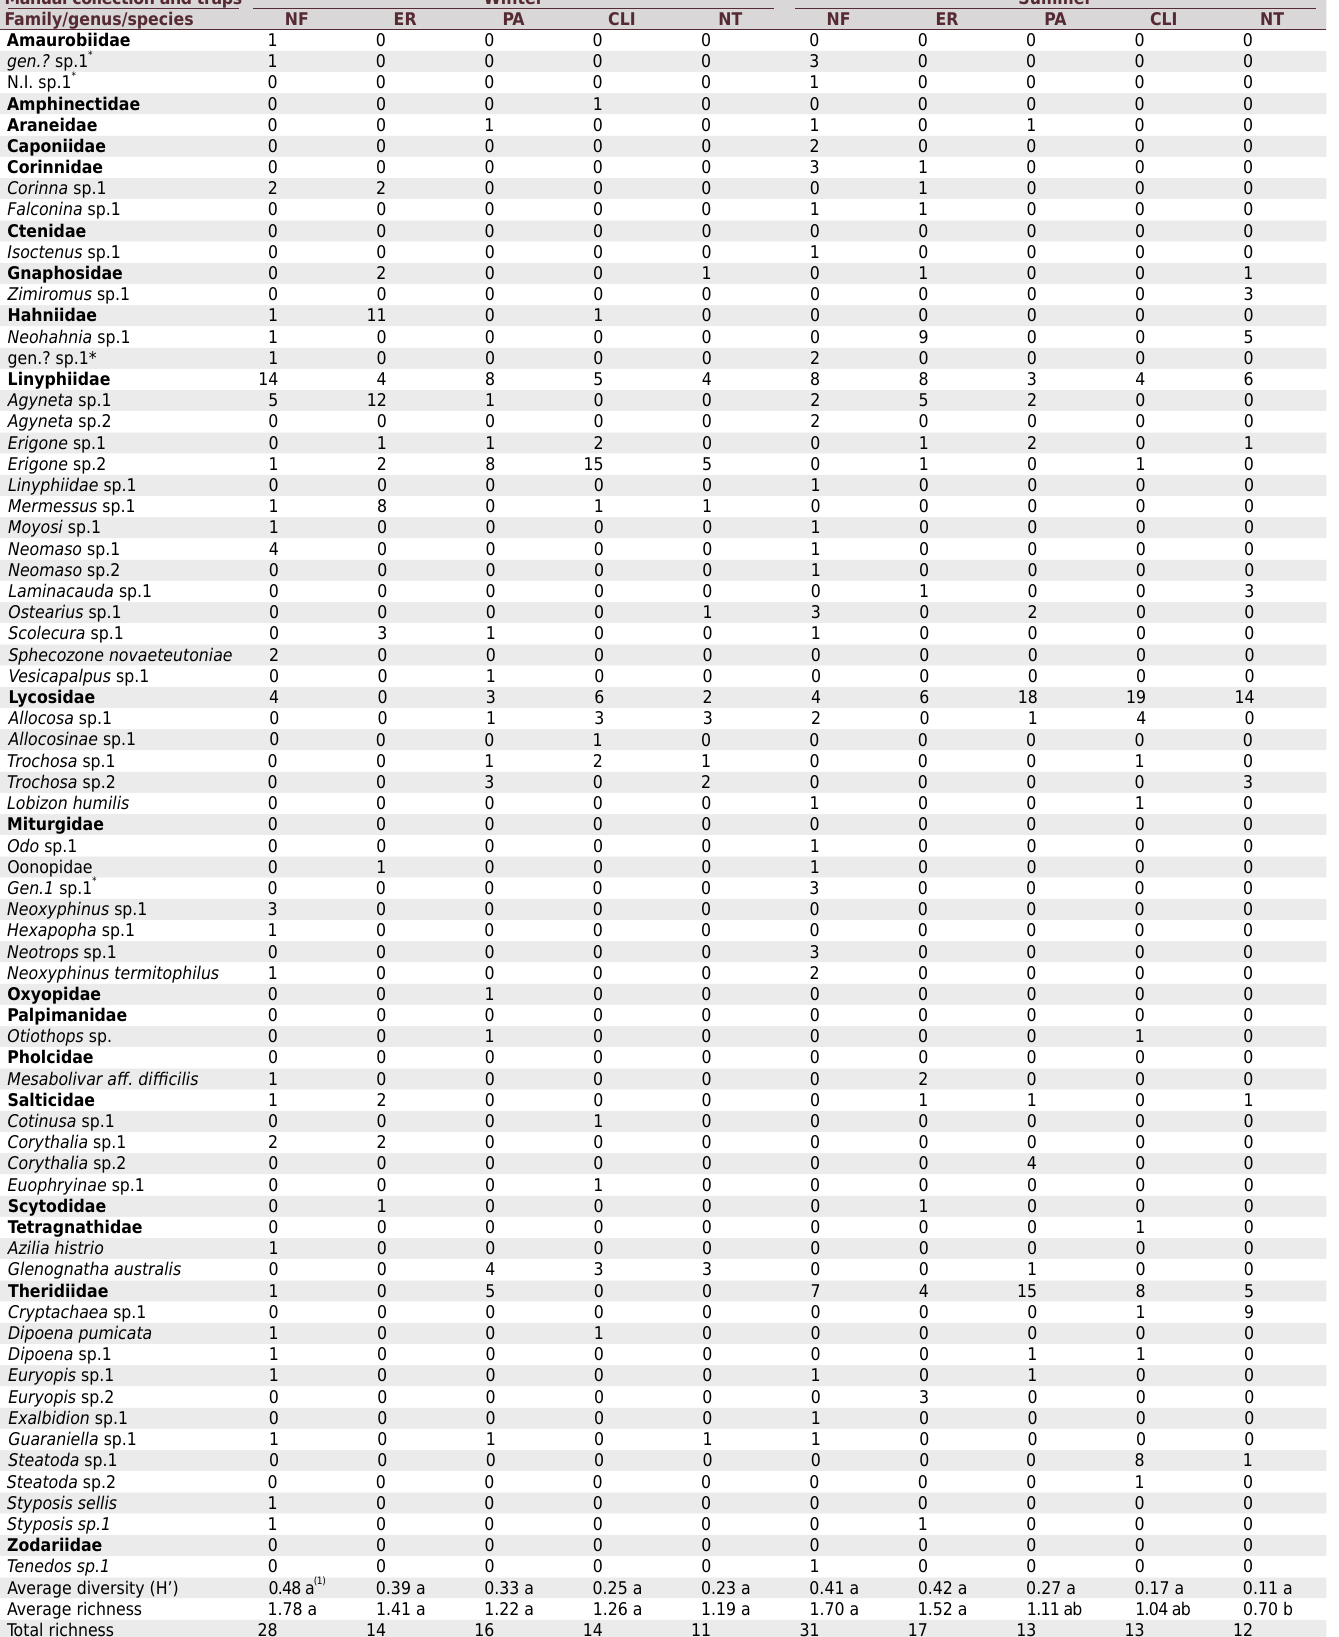
Table 3. The total number of individuals (spider families) caught in western Santa Catarina by the combination of two sampling methods (manual collection and soil traps) in two contrasting seasons (winter and summer) in native forest (NF), eucalyptus reforestation (ER), pasture (PA), crop-livestock integration (CLI), and no-tillage annual crop (NT) Manual collection and